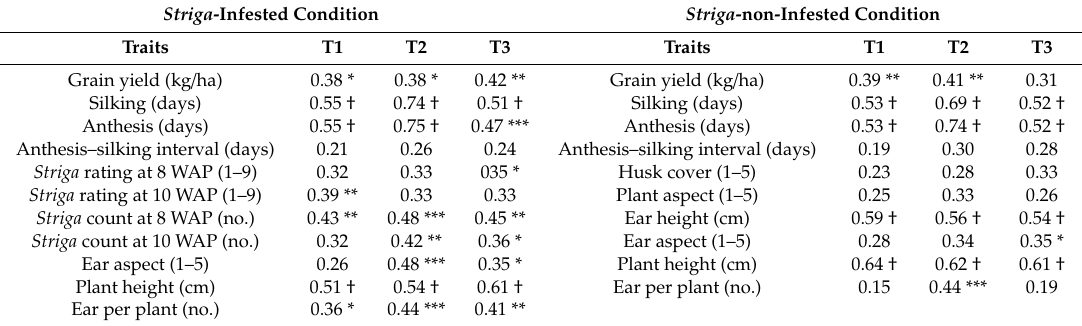
Table A5. Kendall’s coe ffi cient of concordance (W) based on BLUP for ranks of yellow maize inbred lines by each tester across environments under Striga -infested and non-infested conditions.